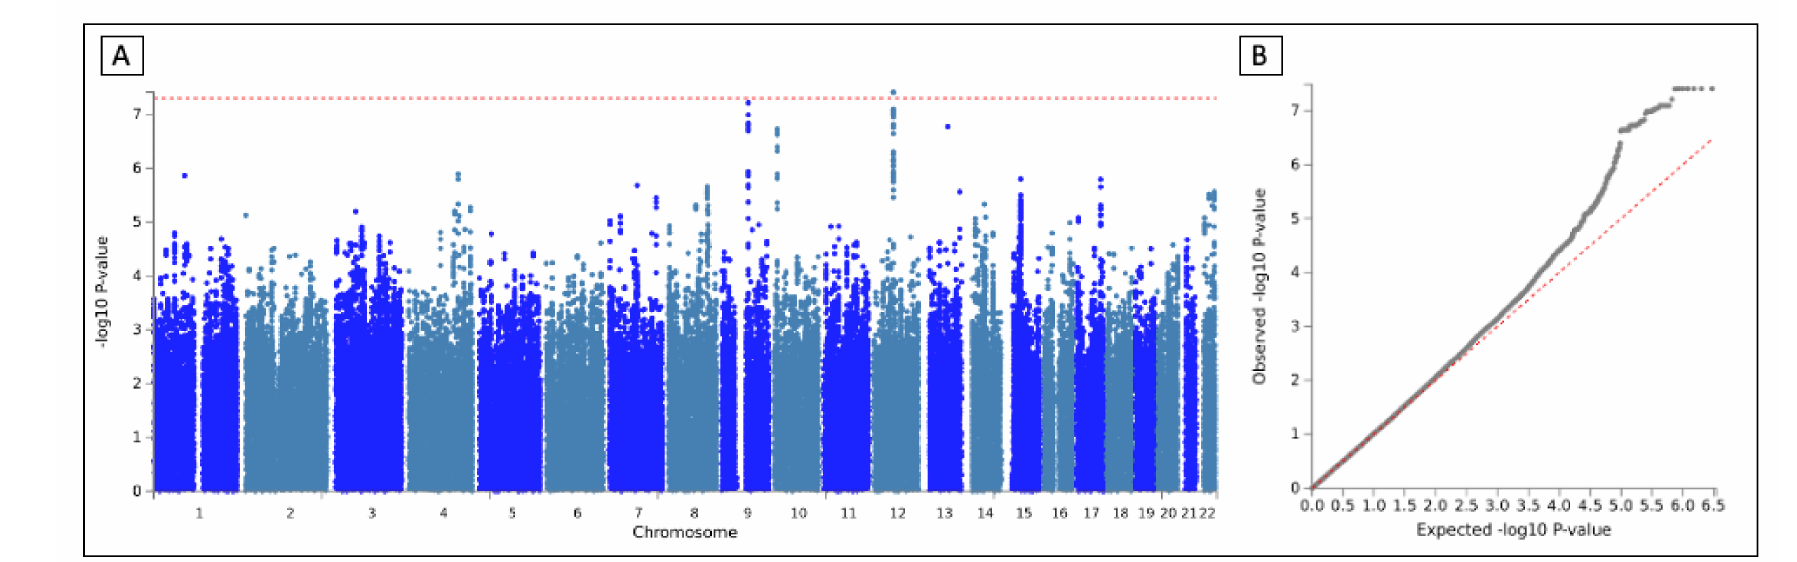
Figure 2. Manhattan and QQ plot of the meta-analysis. ( A ) Manhattan plot. SNVs were represented by dots and plotted based on their genome-wide association study p -values. Red line shows genome-wide significance ( p -value < 5 × 10 − 8 ). ( B ) QQ plot of the p -values obtained after the association testing. The x-axis represents the expected − log 10 — p -value under the null hypothesis and lambda is the median of the resulting chi-squared test statistics divided by the expected median of the chi-squared distribution under the null